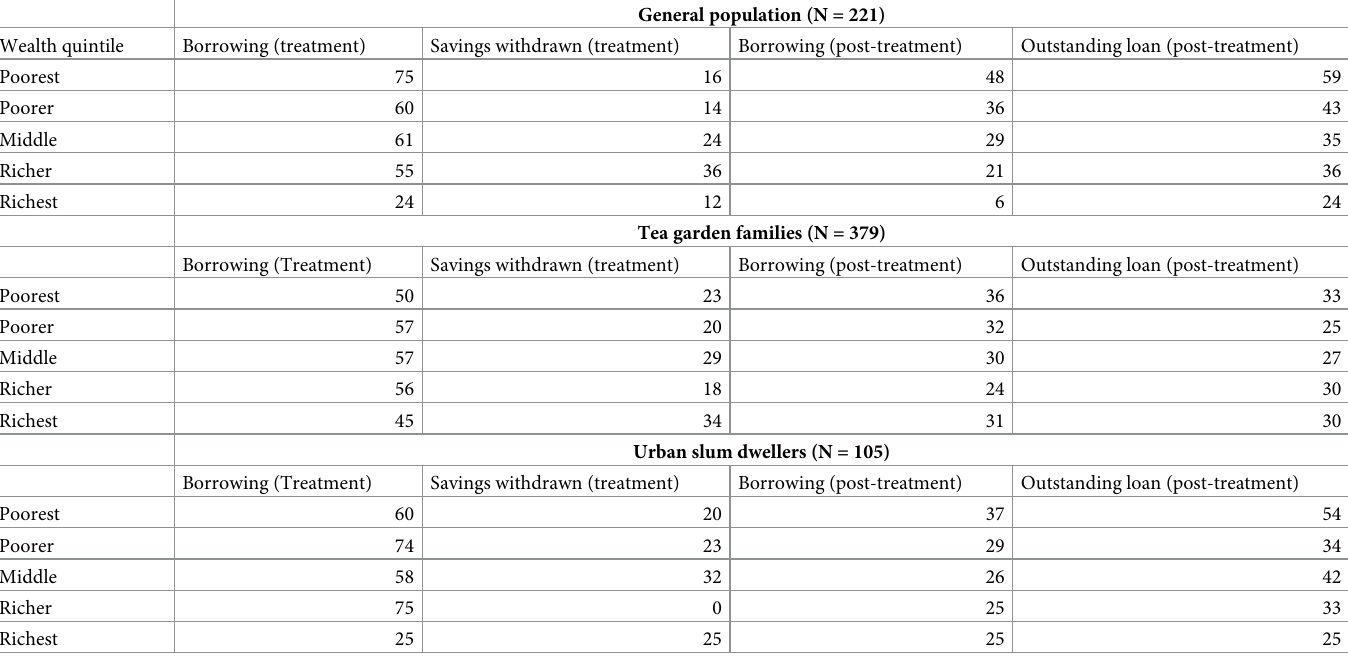
Table 5. Proportion of households used coping strategies by wealth